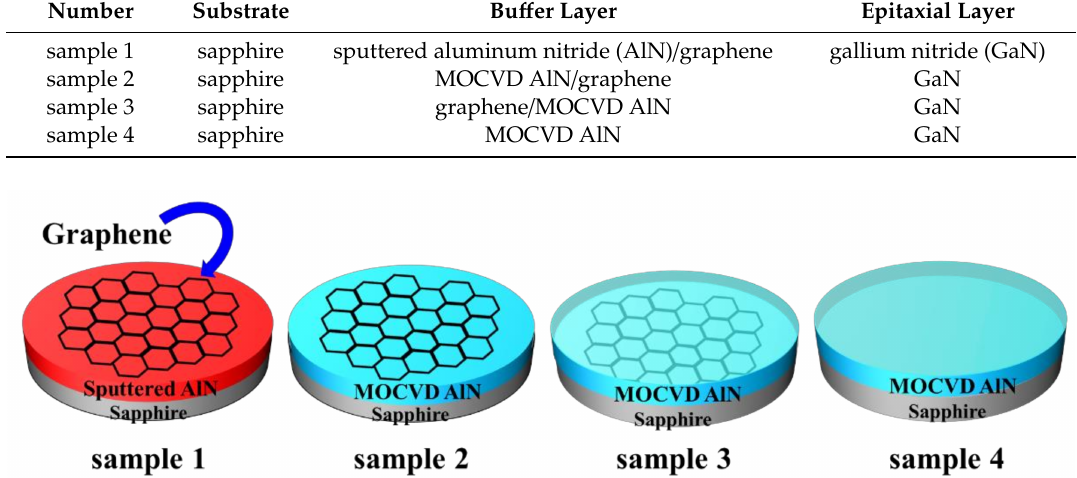
Figure 1. Schematic diagram of the sapphire substrate structure with di ff erent bu ff ers: sample 1 with graphene / sputtered AlN bu ff er, sample 2 with graphene / MOCVD AlN bu ff er, sample 3 with MOCVD AlN / graphene bu ff er, and sample 4 with MOCVD bu ff